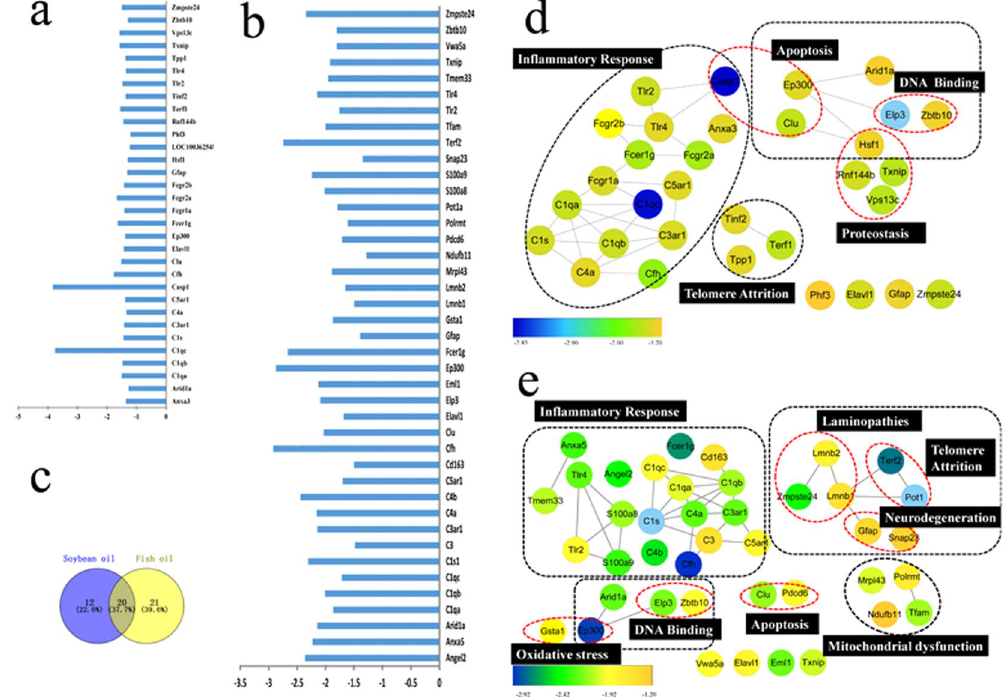
Figure 4. Aging-related PCR array of rat livers in response to soybean oil and fish oil as compared to the lard group. ( a ) 32 differentially expressed genes in the soybean oil group as compared to the lard group (P < 0.05); ( b ) 41 differentially expressed genes in the fish oil group as compared to the lard group (P < 0.05); ( c ) Venn plot of differentially expressed genes; ( d ) Gene set network of hepatic aging PCR array analysis of the soybean oil group as compared to the lard group. ( e ) Gene set network of hepatic aging PCR array analysis of the fish oil group as compared to the lard group. The networks were generated by STRING10 (http://string-db.org/) and Cytoscape 3.3.0. The node color change from blue to orange represents an increase of P value from − 2.83 to